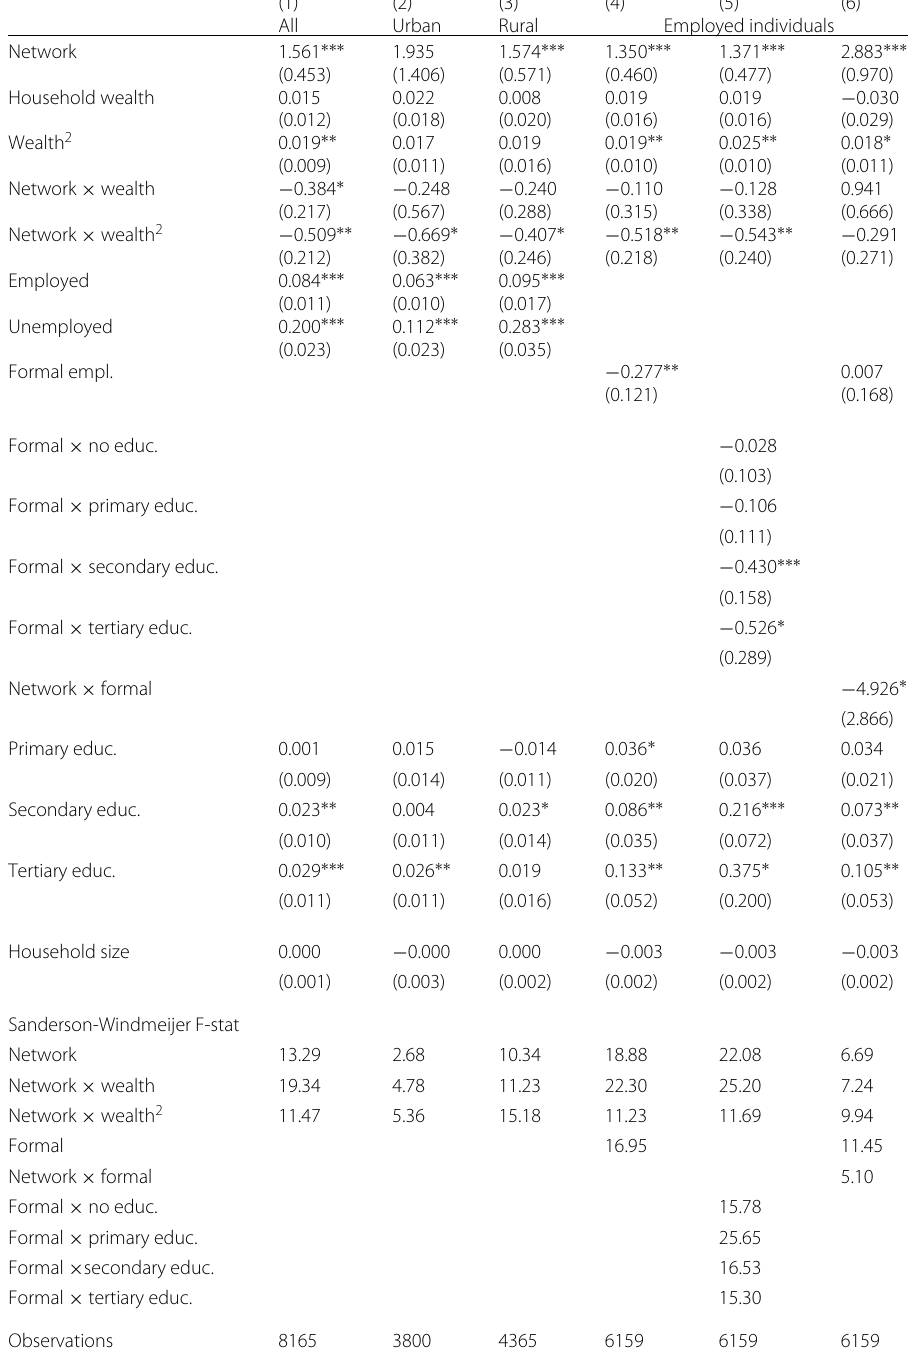
Table 8 Individual determinants of emigration: Labor market factors, IV results (1) (2) (3) (6) All Urban Rural Employed individuals Network